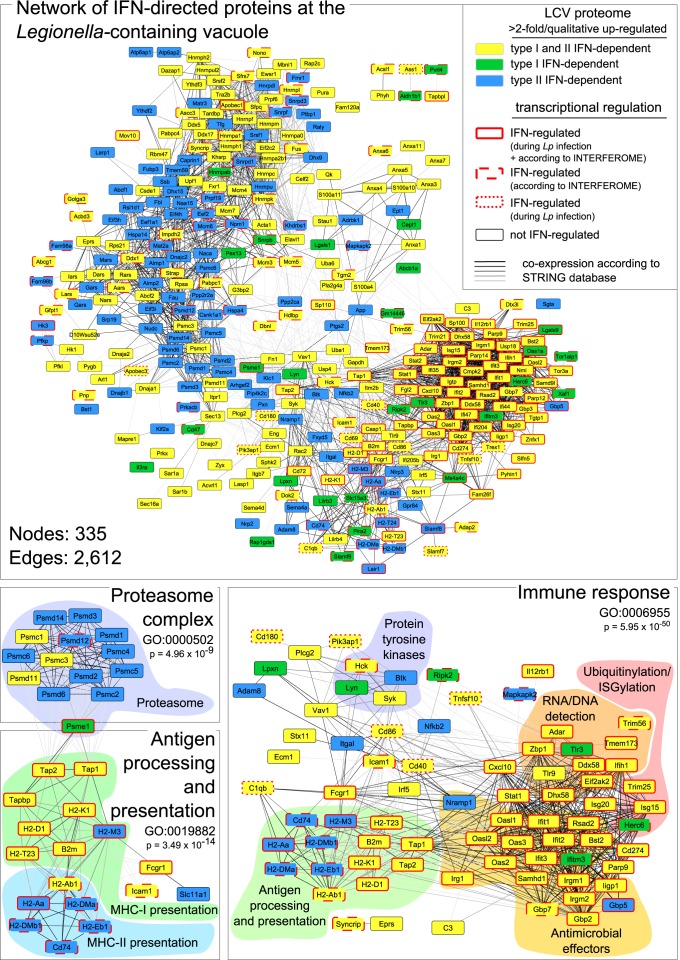
Integrated network analysis of IFN-regulated proteins of the LCVs.Proteins with higher abundance at LCVs from IFNβ- and/or IFNγ-treated compared to untreated cells were analyzed with the STRING database. The proteome data were further compared with the whole genome microarray data (S1 Dataset; genes > 2-fold higher expressed and p < 0.05 in infected WT vs. Ifnar/Ifngr
-/- mice) and the INTERFEROME database to indicate molecules which are also transcriptionally regulated by IFNs. A GO enrichment analysis was performed for extracting significant subnetworks of a complex network composed of 335 nodes and 2,612 edges. Shown are subnetworks positively affected by IFNβ and/or IFNγ activation such as ‘immune response’, ‘antigen processing and presentation’ and the ‘proteasome complex’.